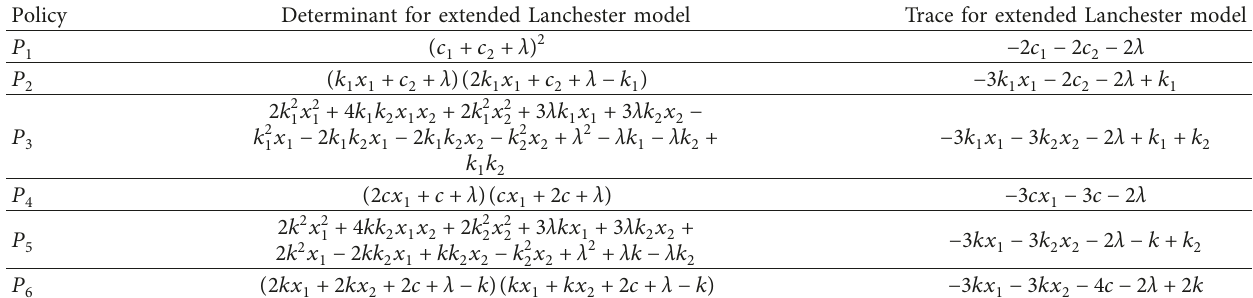
Table 7: Expressions for determinants and traces in extended Lanchester model (12) under special cases of affine feedback advertising policy.